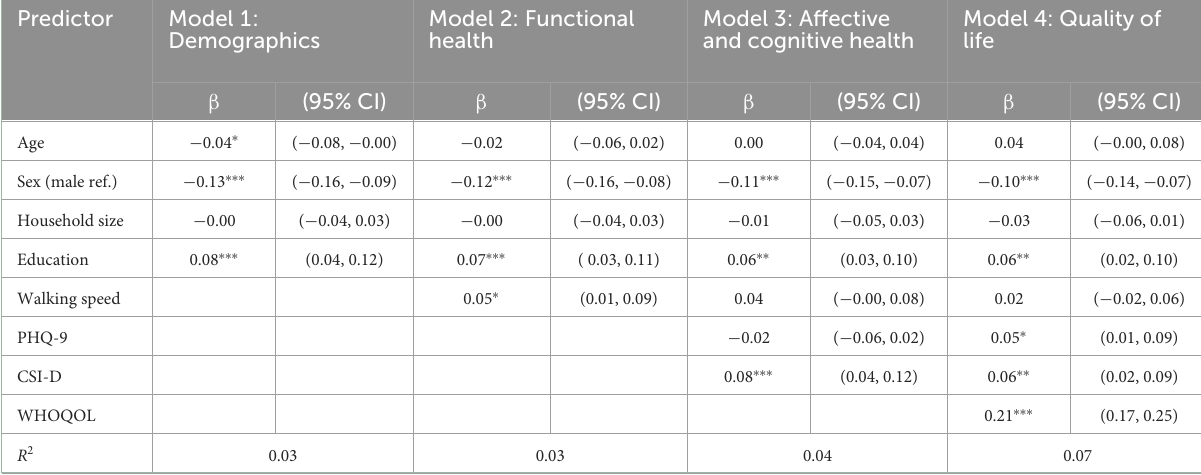
TABLE 2 Hierarchical regression for the association of health variables to AARC-gains as an outcome (Burkina Faso sample; N = 3,028). Predictor